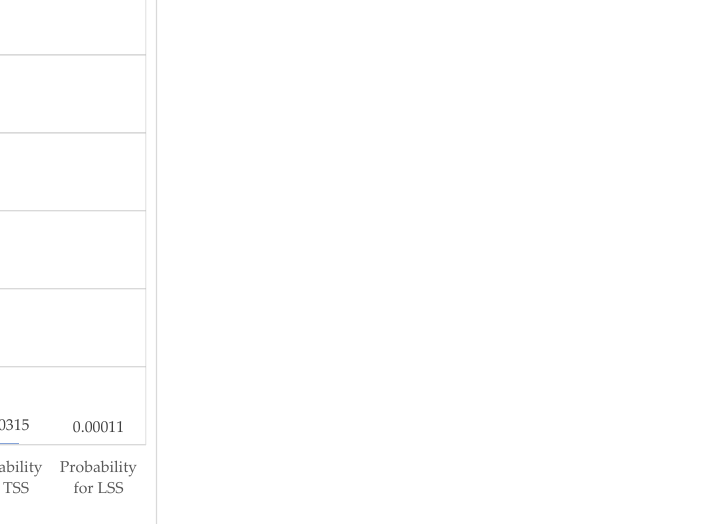
Figure 1 2. Transition probabilities corresponding to individual states —P CSS , P TSS , and P LSS . Figure 12. Transition probabilities corresponding to individual states—P CSS , P TSS , and P LSS